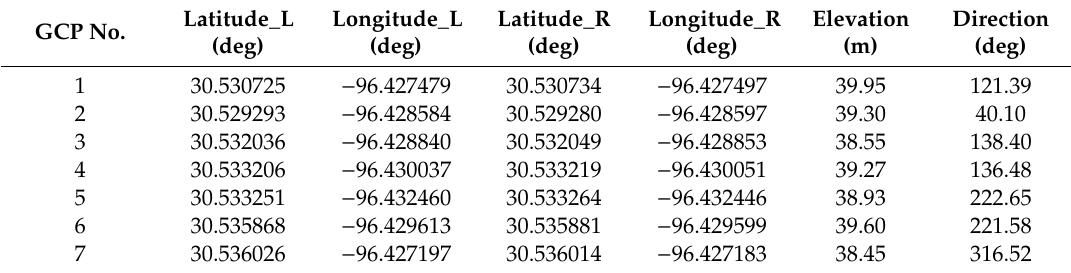
Table 4. Format of the GPS data of the GCPs recorded in a txt file on the UAV. GCP